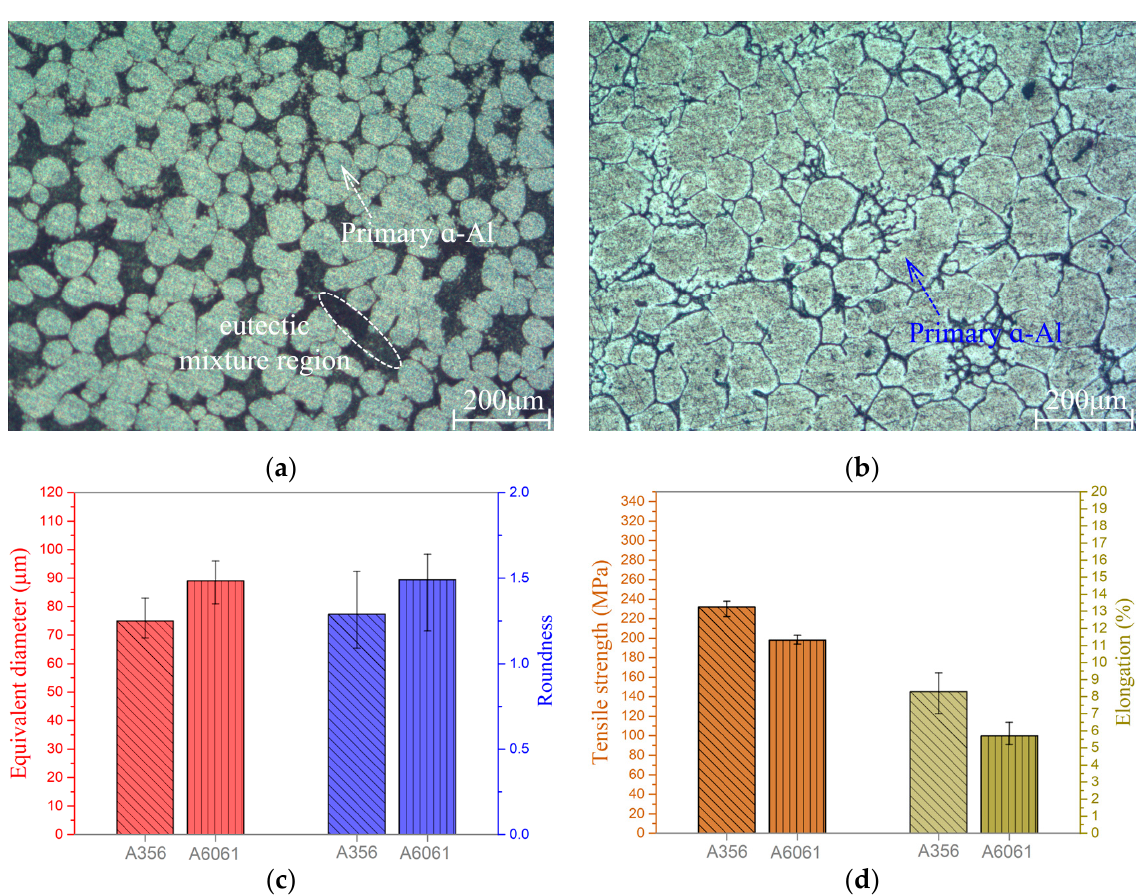
Figure 6. Semi-solid billet by thixo process (reheating) after rheo process and upsetting: ( a ) A356 microstructures; ( b ) A6061 microstructures; ( c ) equivalent diameter and roundness of primary α -Al grains; ( d ) tensile strength and elongation.